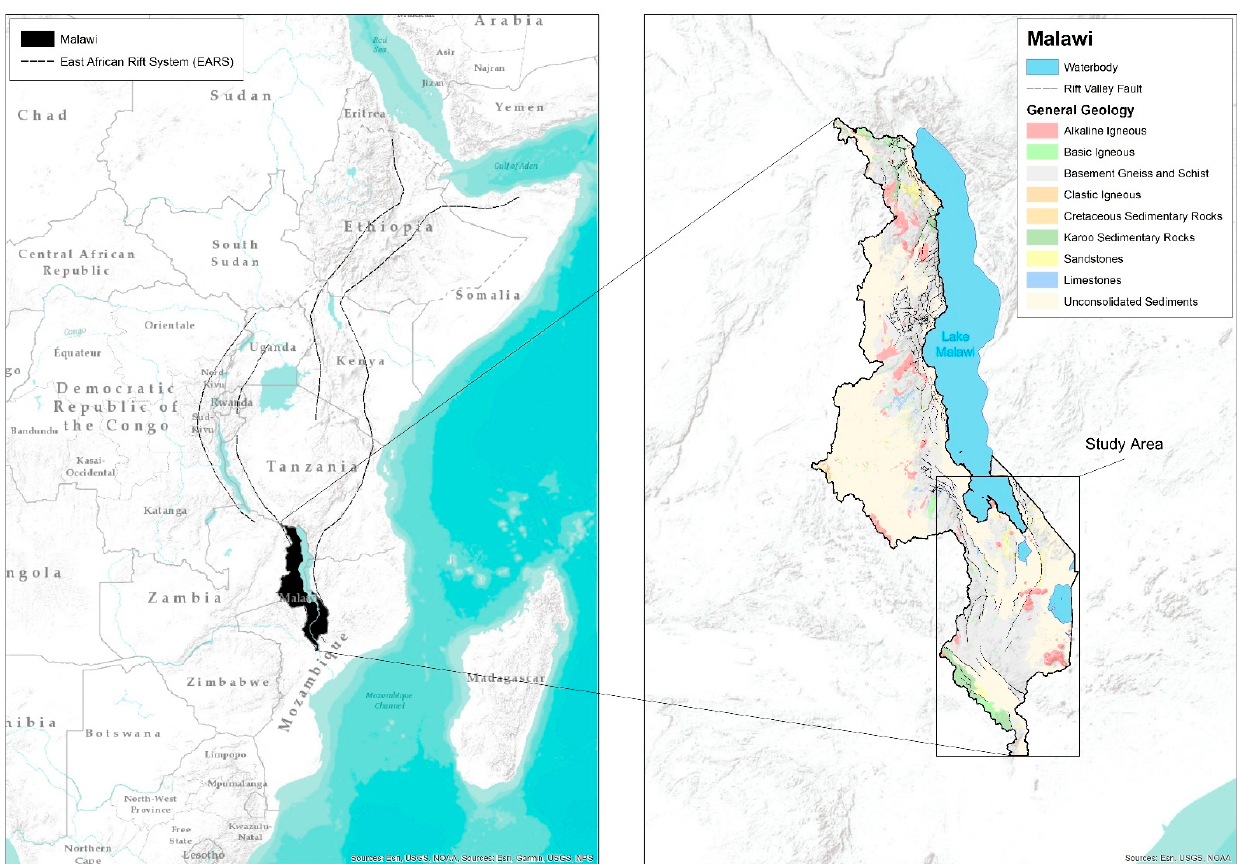
Figure 1. Left Malawi’s location on the African continent at the southern periphery of the East African Rift System (EARS). Right Topographical map of Malawi with generalised geology and rift-related faulting within the Malawi Rift Valley. While there is no volcanism in Malawi, active rifting (evidenced by regular earth- quakes) still occurs [21] and it is those active rift-related normal faults which control the upwards migration of hydrothermal groundwater from depth to hot springs [24]. Exten- sional strain is accommodated across both rift margin and intrabasin faults which is re- garded significant in that hydrothermal activity is as probable within the rift valley as it is at the margins where the largest faults occur [25]. That was apparent in our previous work [15]—two rift basin hot springs appearing anomalous due to an absence of nearby faults were attributed to a recently discovered intrabasin fault [25], coincident with their location causing local hydrothermal activity. The wider inference being that intrabasin faults hidden beneath sediments may be responsible for hidden hot springs at the sedi- ment base elsewhere, which due to their (hypothesised) hidden locations beneath sedi- ments would require proxy indicators to locate and identify. Malawi additionally hosts two hot springs which are located outside of the rift and not associated with faults. The hot springs (discussed later) appear to be related to adjacent Chilwa Alkaline Province (CAP) intrusions; igneous intrusions associated with the most recent phase of rifting where the intrusion-country rock lithological boundary acts as the vertical transport con- duit for hydrothermal groundwater (Figure 2). The CAP intrusions outcrop extensively across southern Malawi and may provide additional (residual) heat to hydrothermal sys- tems in the region [17].